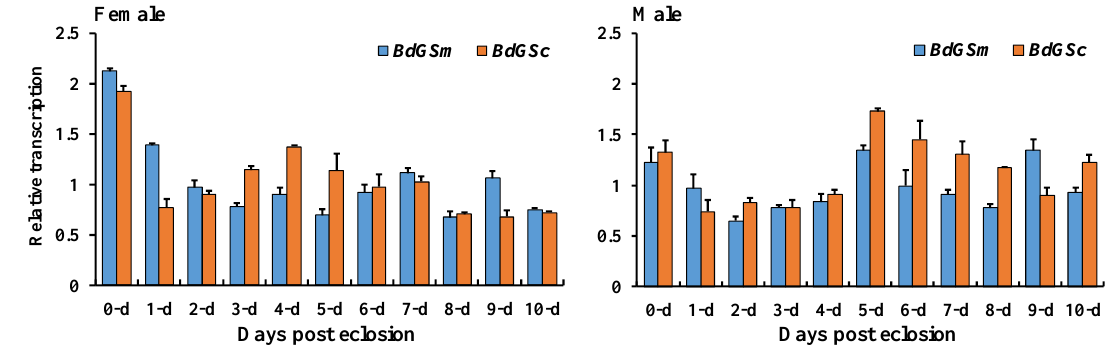
Figure 1. Gene expression of BdGSm and BdGSc during female and male adult post-eclosion. The gene expression was calculated by qBase Plus software. The bar represents the mean gene expression and the error bar represents the positive standard error of the mean.